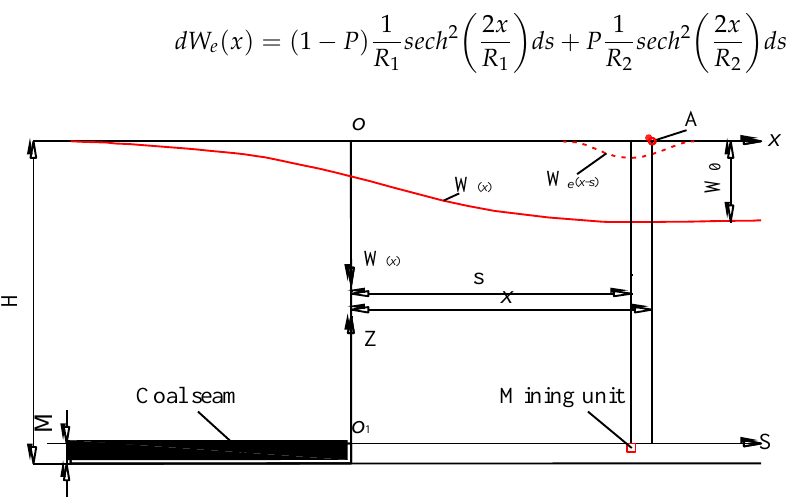
Figure 5. Surface subsidence during semi-infinite mining.